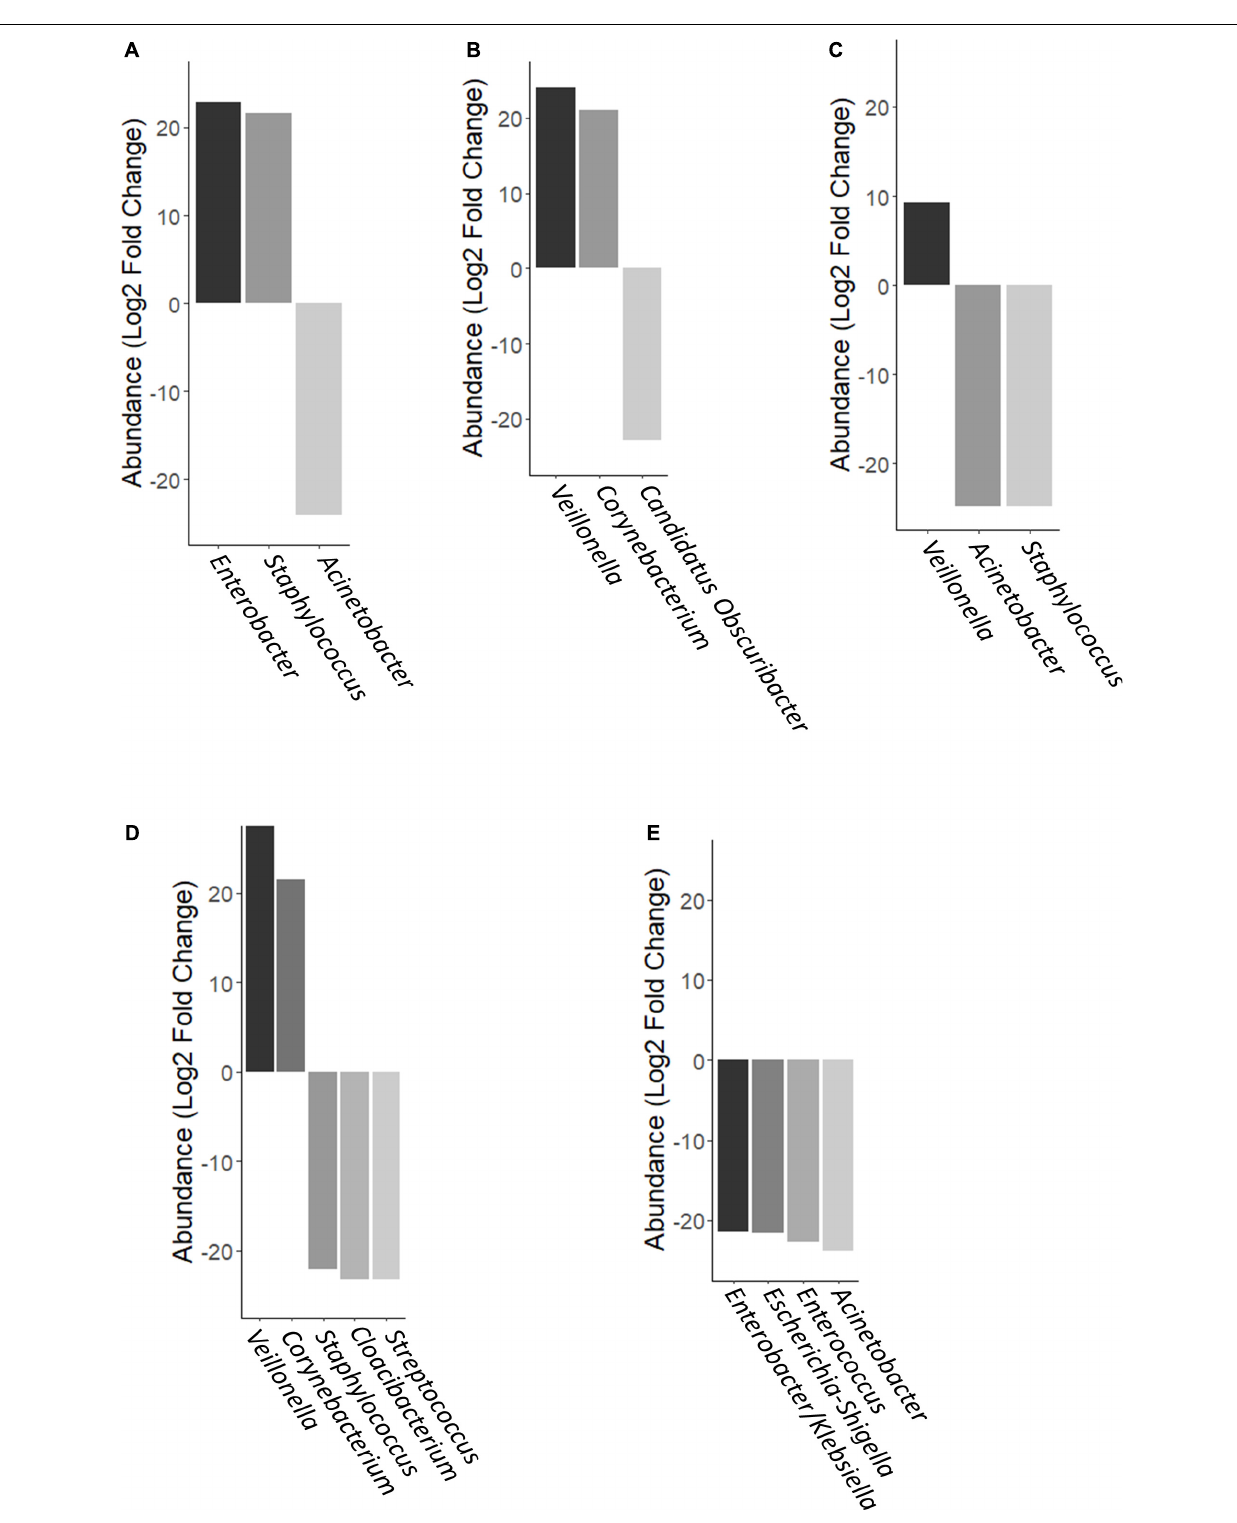
Frontiers in Microbiology |